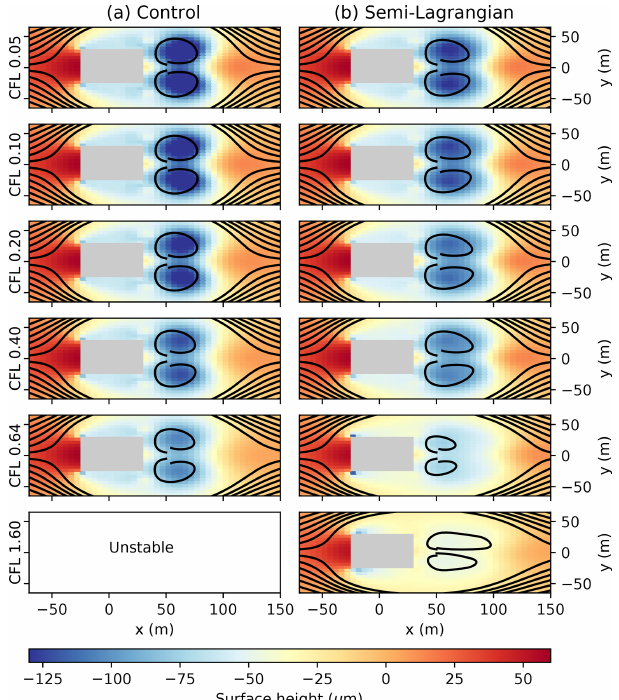
Figure 5. Free-surface height and streamlines for the test case of Sect. 5.1, after 8000s for (cid:49)t = 5, 10, 20, 40, 64, and 160s (top to bottom, with the approximate Courant number listed). Results for the Eulerian advection scheme are shown in (a) , and results for the semi-Lagrangian advection of momentum are shown in (b) . As the time step increases both advection schemes show more diffuse be- haviour; however the semi-Lagrangian advection scheme remains stable to (cid:49)t = 160s, whereas the Eulerian scheme becomes unsta- ble after (cid:49)t =